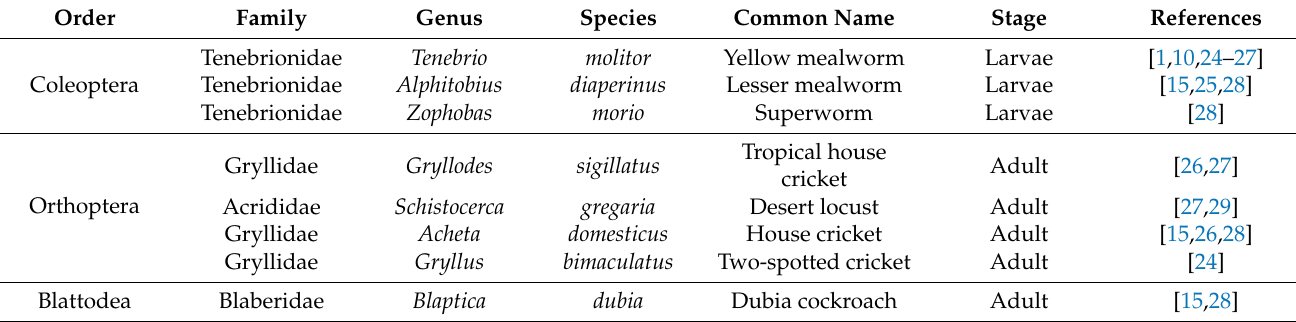
Table 1. The most commonly used edible insect species in protein extraction processes.